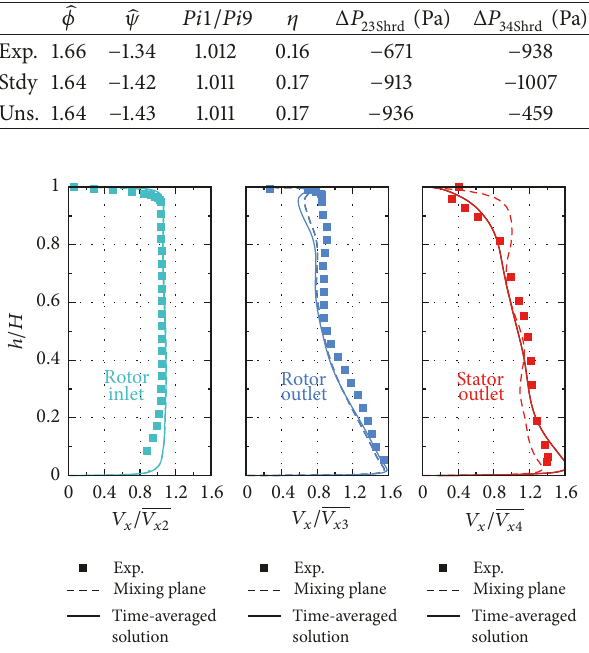
Figure 4: Experimental and numerical rotor and stator axial velocities.